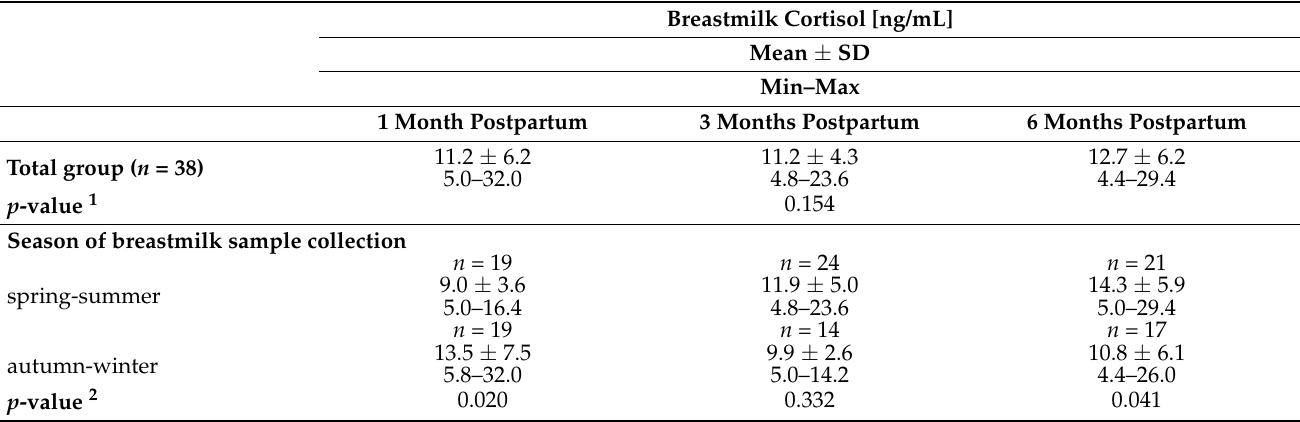
Table 2. Breastmilk cortisol at 1, 3, and 6 months postpartum according to the season of breast- milk